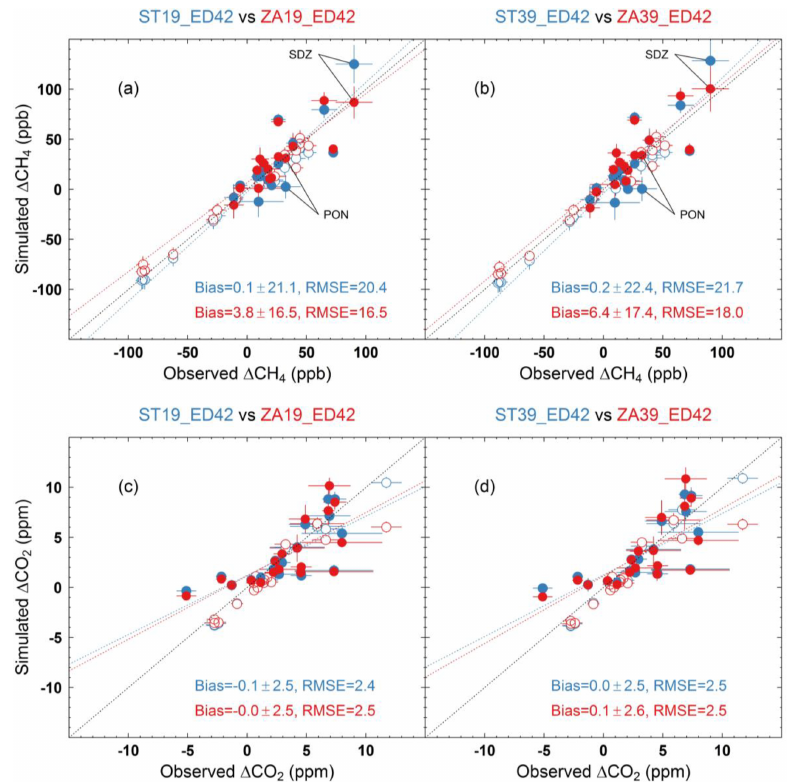
Figure 2. Scatterplots of the simulated and observed mean annual gradients of CH 4 (a, b) and CO 2 (c, d) between HLE and other stations. In each panel, the simulated CH 4 or CO 2 gradients are based on model outputs from STs (blue circles) and ZAs (red circles), respectively. The black dotted line indicates the identity line, whereas the blue and red dotted lines indicate the corresponding linear fitted lines. The closed and open circles represent stations inside and outside the zoomed